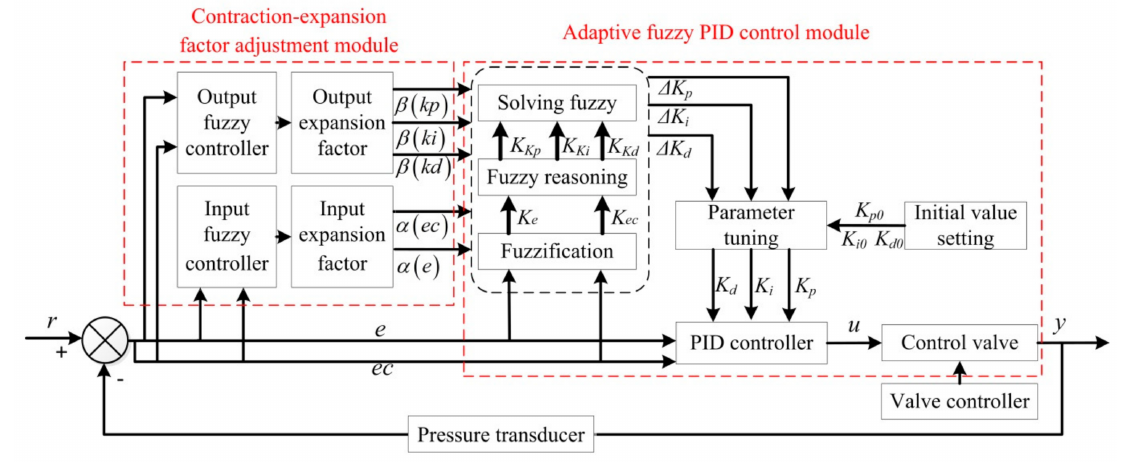
Figure 10. Variable universe fuzzy PID control principle